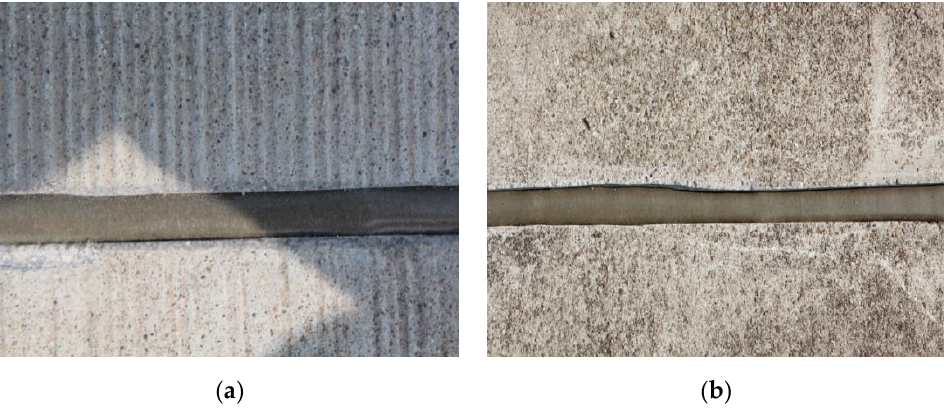
Figure 14. Brief application process. ( a ) Blowing joints by high pressure air gun. ( b ) Injecting the PCFC.